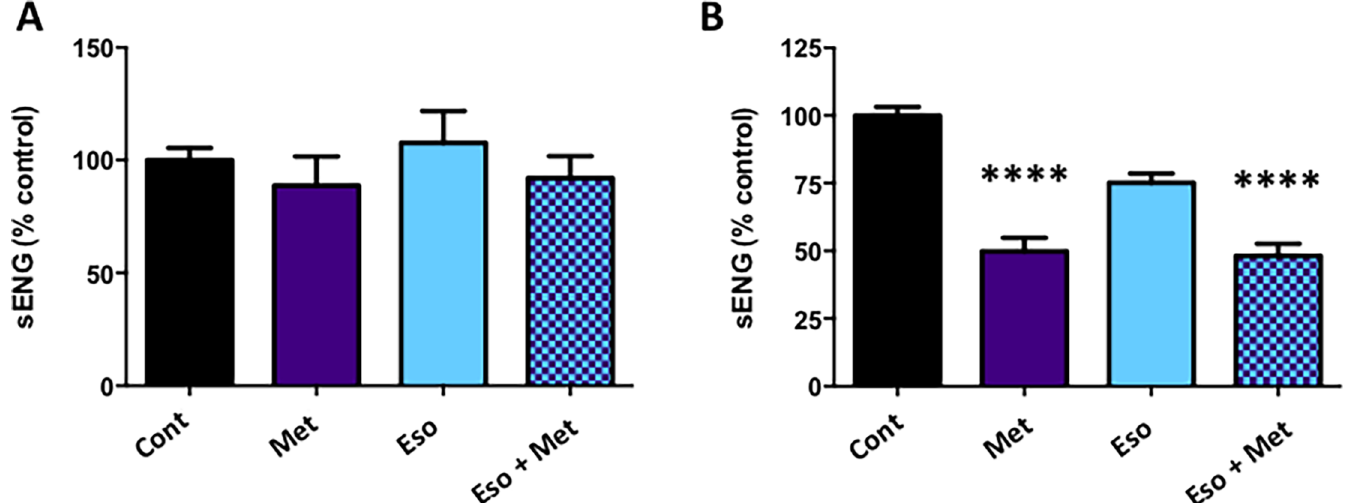
Fig 2. Combination of metformin and esomeprazole are not additive in reducing sEng secretion. Levels of secreted sEng were measured in media collected from placental explant tissue (A) and human umbilical vein endothelial cells (HUVECs) (B), treated with either metformin (Met), esomeprazole (Eso) or Met + Eso in combination. No effect on placental explant secretion of sEng was observed for the drugs alone or in combination (A). In primary HUVECs, Met alone, and Met + Eso caused a significant reduction in sEng secretion from HUVECs compared to control (B). The following treatment doses were used: Placental explant tissue : Met; 500 μ M, Eso; 25 μ M or same doses in combination. HUVECs :Met; 1000 μ M, Eso; 25 μ M or same doses in combination. All treatments were carried out over 48 h. Data are mean fold change from control ± SEM ( (cid:3)(cid:3)(cid:3)(cid:3) p < 0.0001 compared to control). (n (cid:21) 3).